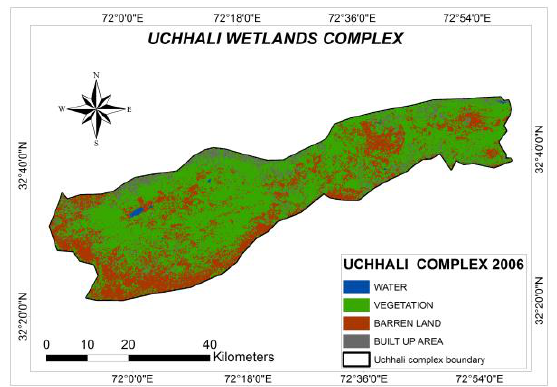
Figure 3. Classified map of Uchhali Complex